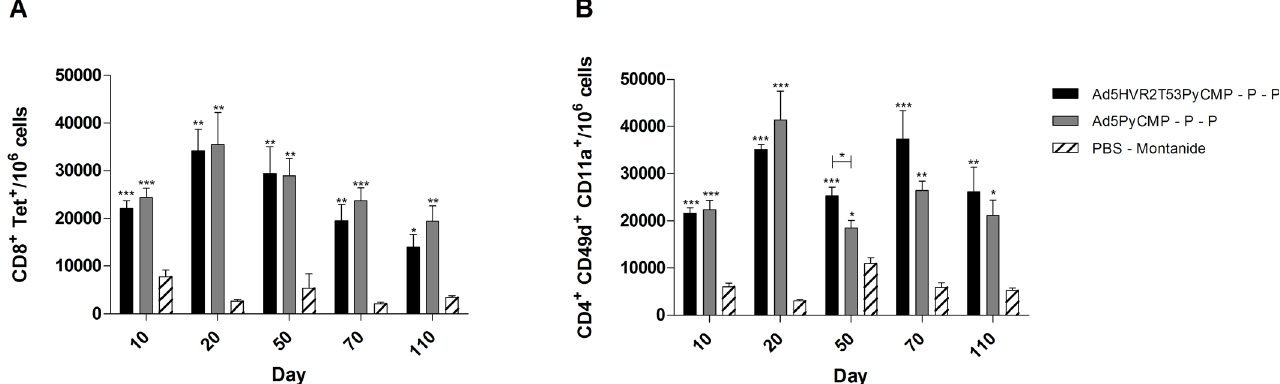
Fig 7. Cellular Responses induced by the vaccination regimen based on the Ad5HVRT53PyCMP vector. CB6F1/J (n = 5 per group) mice received the regimens described in Fig 6. PBMC derived from mice whole blood were obtained during the immunization schedule on the days stated in the graph and were processed by flow cytometry, (A) CD8+ T cells able to recognize the P . yoelii CSP tetramer H-2K d /SYVPSAEQI. (B) CD4+ T cells expressing CD49d and CD11 as markers for the differentiation of antigen experienced cells. The results are presented as the number of cells present in 10 6 PBMC. The differences between the groups were analyzed by Kruskal-Wallis test with Dunns post-test, significant statistical differences between the groups are denoted by * (p < 0.05) ** (p < 0.01) *** (p <